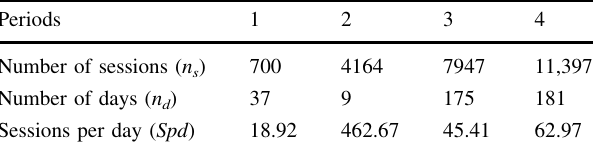
Table 2 #italiasicura data on sessions in the four identified periods in the time from 14 April 2015 to 20 May